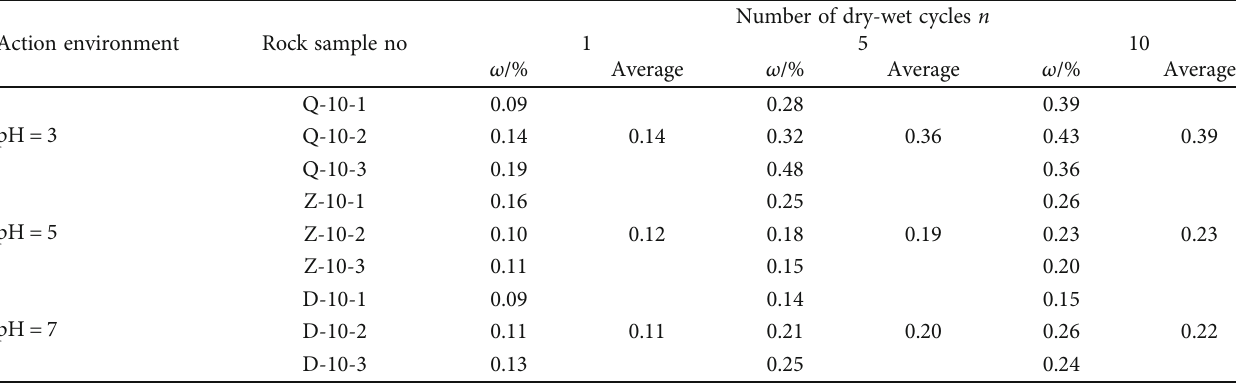
Table 6: The changing conditions of the limestone saturated water absorption rate after di ff erent numbers of dry-wet cycles in di ff erent environments.